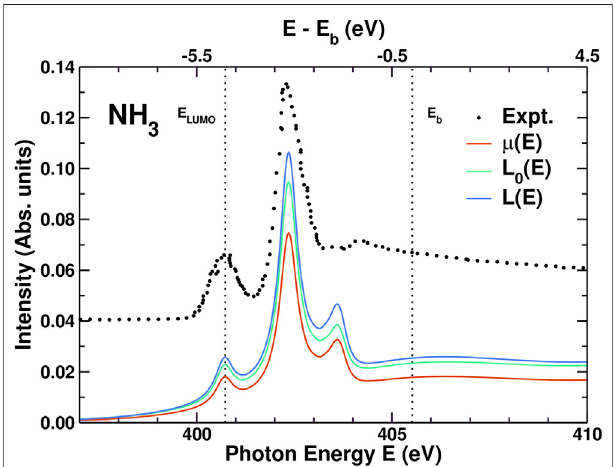
FIGURE 4 | Comparison of the experimental XAS μ ( E ) for NH 3 (Wight and Brion, 1974) vs photon energy E to those calculated from the convolution in Eq. 2 , the effective one-body XAS L ( E ) (cid:2) μ 1 ( E ) and the independent particle XAS L 0 ( E ) (cid:2) μ 0 ( E ) from Eq. 25 . The N x-ray K edge lies just under E LUMO while E b is the ionization threshold. In order to account for the sparsity of the Gaussian-type orbital basis set in the continuum region above E b , the comparison to experiment includes variable broadening (see text) that increases to a maximum of 3.5 eV above E b